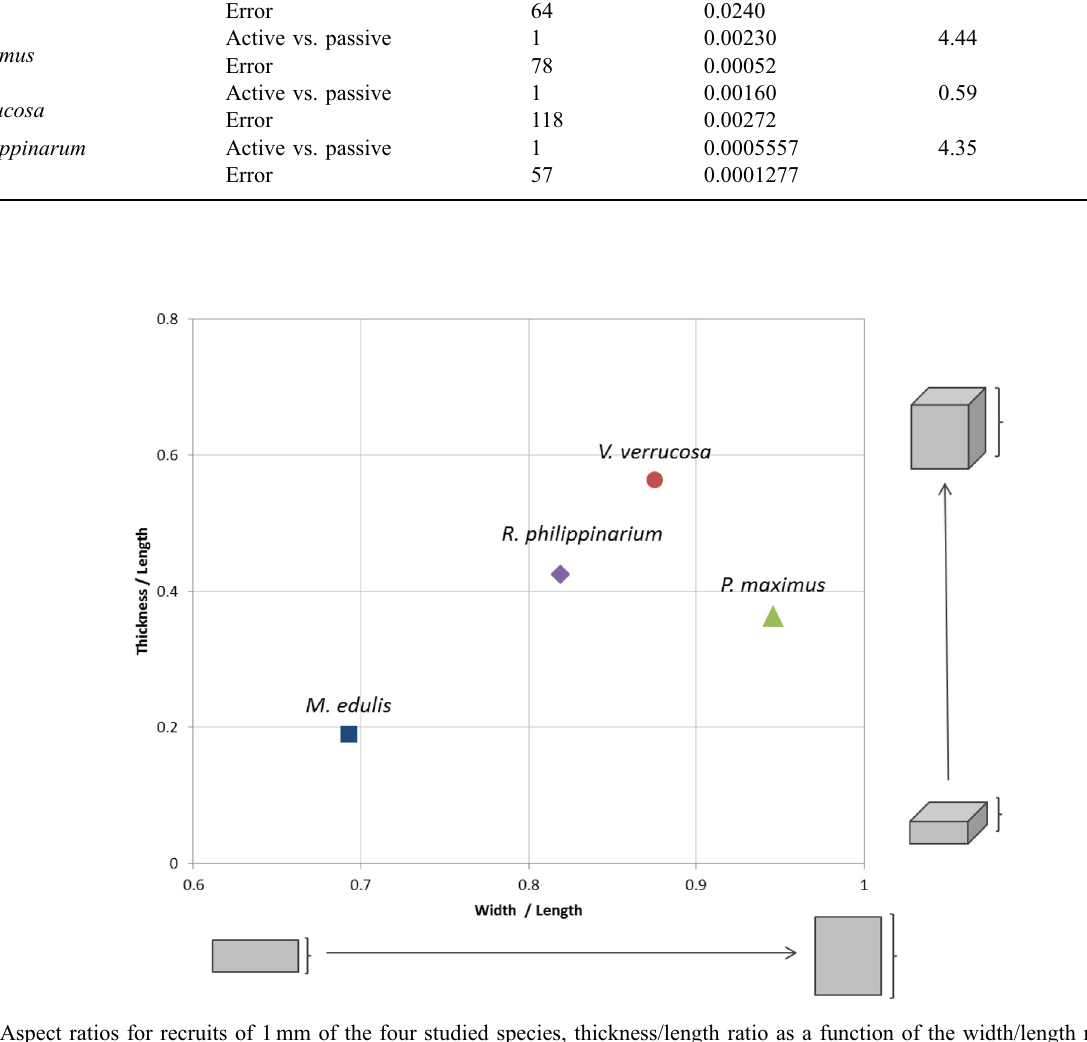
Fig. 2. Aspect ratios for recruits of 1mm of the four studied species, thickness/length ratio as a function of the width/length